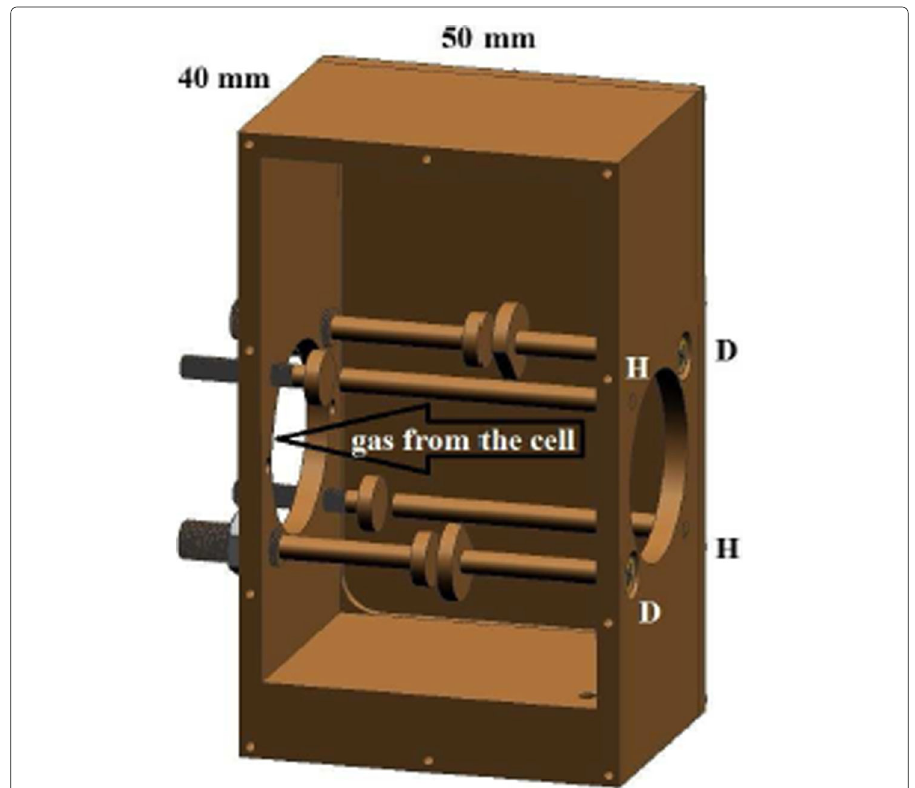
Fig. 8 The SFT H-D dual cavity [28]. Coupled rods for H and D are tilted by 45 ◦ with respect to the homogeneous and gradient